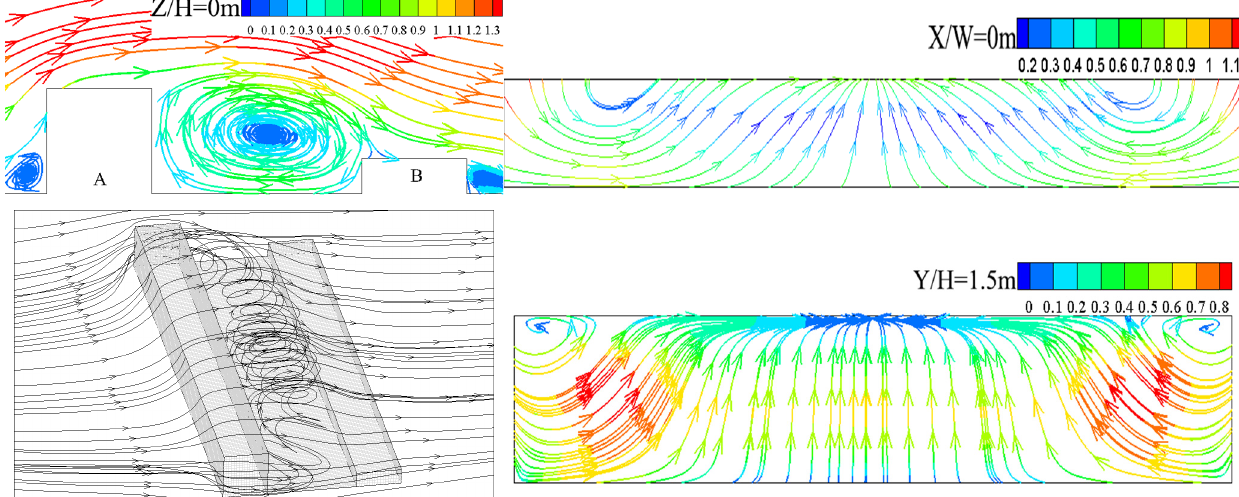
Figure 11. Plane streamline diagram and 3D flow field diagram in the step-down street canyon with ASF = 3/1.